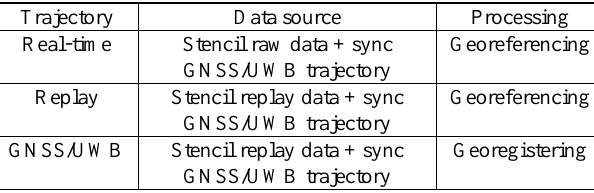
Table 4. Type of processing used to combine KAARTA Stencil 2 raw data, GNSS data and UWB data.